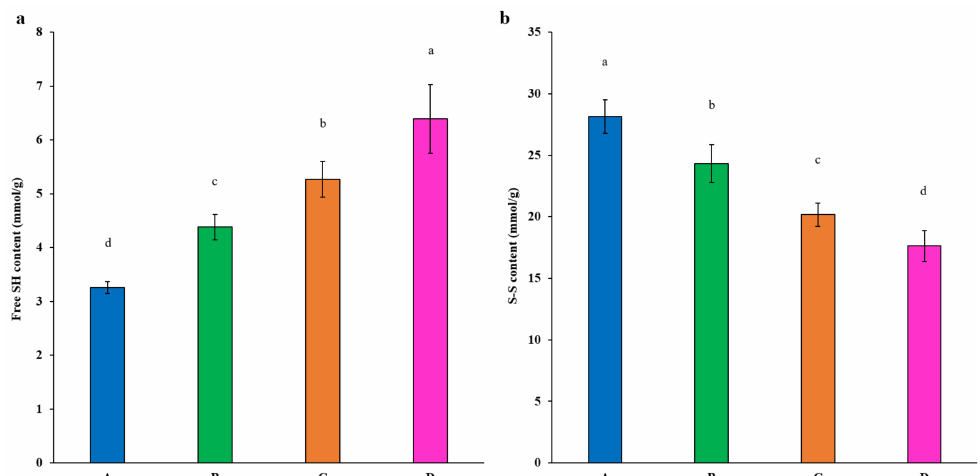
Figure 5. ( a ) Sulfhydryl and ( b ) S-S contents of rice protein. Lowercase letters in the same column indicate significant differences according to Duncan’s multiple range tests ( p <